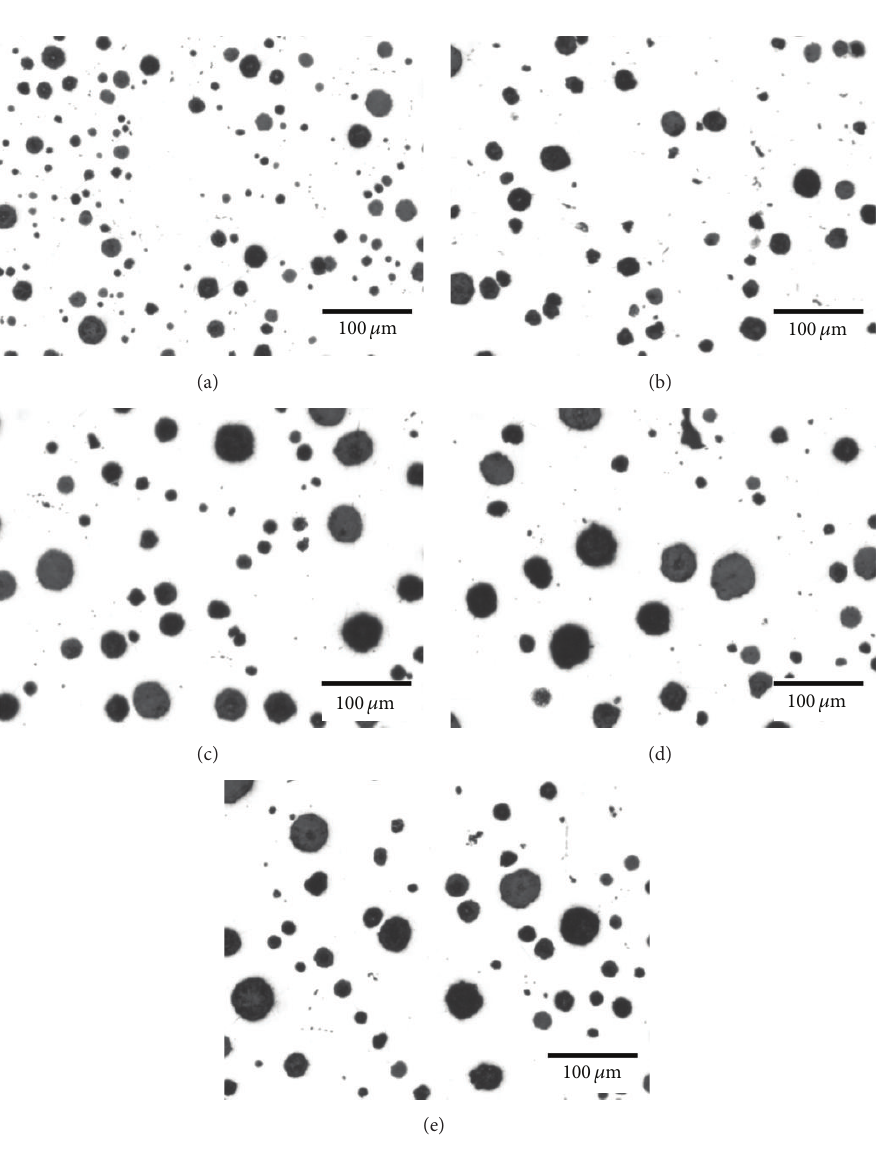
Figure 6: Characteristic images of each section at a magnification of 200x and number of images taken from each: (a) section 1, 26 images; (b) section 2, 38 images; (c) section 3, 37 images; (d) section 4, 48 images; (e) section 5, 46 images.